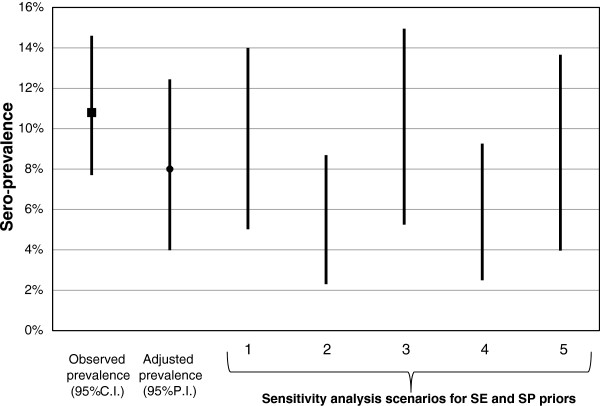
Sensitivity analysis of the choice of priors for assay sensitivity (SE) and specificity (SP) on the Bayesian adjusted estimate of toxoplasmosis sero-prevalence in a population of children from Wisconsin, United States, 1997–1999. Sensitivity analysis included various scenarios for most likely value while keeping the range provided by expert opinion. 1: SE >85% and mode = 100%, SP >90% and mode = 100%; 2: SE >85% and mode = 100%, SP >90% and mode = 91%; 3: SE >85% and mode = 86%, SP >90% and mode = 100%, 4: SE > 85% and mode = 86%, SP >90% and mode = 91%; 5: SE 85% - 100%, SP 90% - 100%.